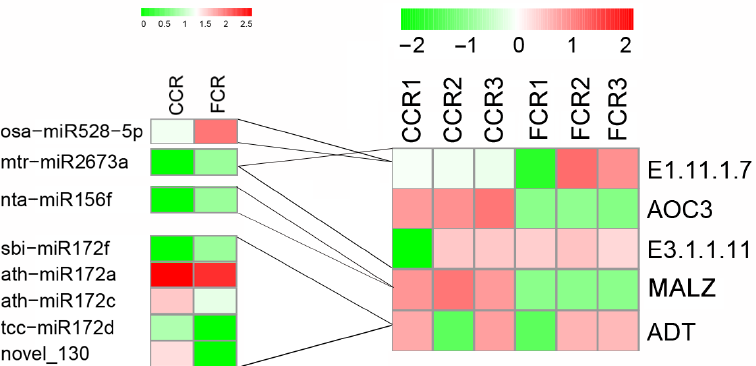
Figure 5. A heatmap displaying differentially expressed miRNAs (DEMs) with their target genes. FCC stands for the root samples of the first cropping, and CCR stands for root samples of consecu- tive